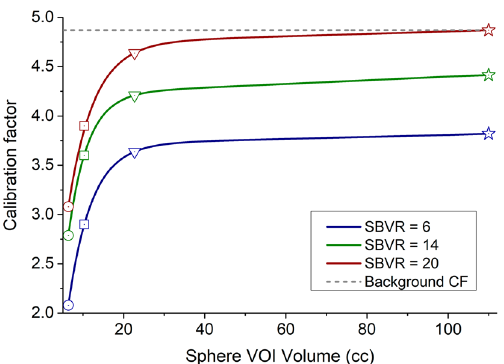
Fig. 5 CF values in cps/MBq versus sphere/lesion volume curves for SBVR values of 6 (blue curve), 14 (green curve) and 20 (red curve). The gray dashed line represents the maximum CF (4.87). The circle, square, triangle symbols show the know CF values for the 5.71, 11.49 and 26.52 cc spheres, respectively, from Fig. 4. The star symbol represents the CF value calculated from the transition factor TF (Eq. 3) for a sphere/lesion volume of 110 cc